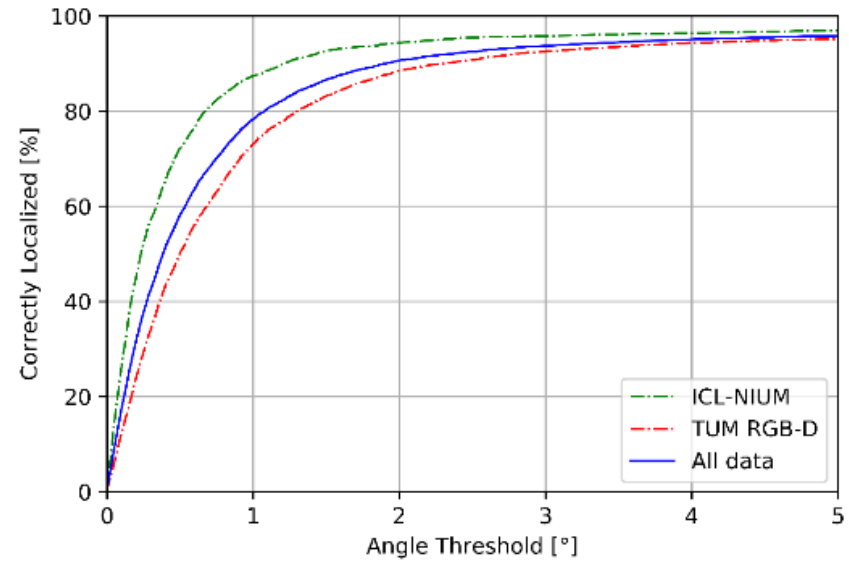
Figure 9. Cumulative distribution function of location error.